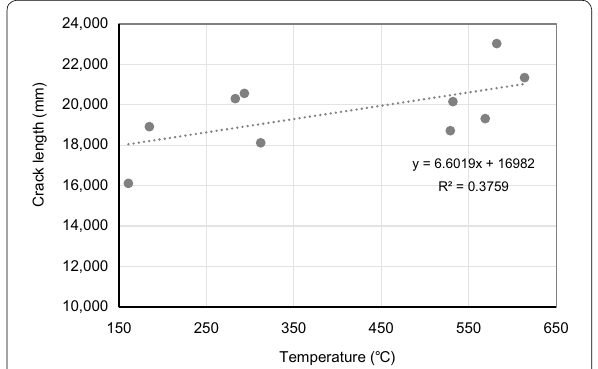
Fig. 11 Correlation between temperatures and crack lengths obtained from the optical observation at different